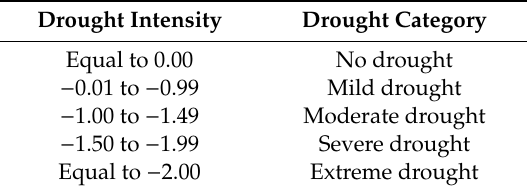
Table 2. Drought classification scheme based on Standard Precipitation Index